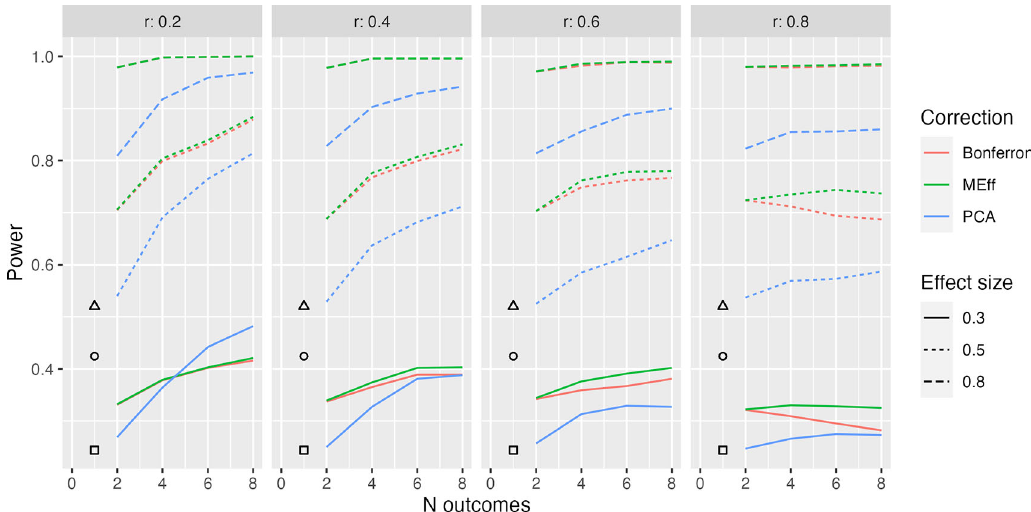
Figure 4. Model L2x: 50 per group. Power in relation to number of outcome measures (N outcomes), intercorrela- tionbetweenoutcomes(columnheaders),typeofCorrection,andEffectsize.Thesquare,circleandtrianglesymbols represent the power for a single outcome measure with effect size .3, .5 and .8 respectively.